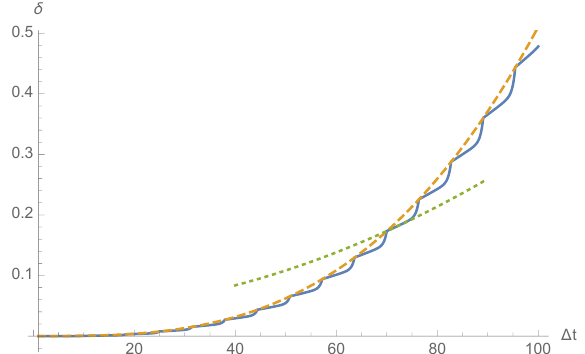
Figure 3. The growth of the eikonal phase δ , related to the OTOC through (1.9), of two scalar op- erators at a fixed spatial separation in extremal BTZ, computed within the geodesic approximation (solid blue line). The growth is cubic on average and can be very well approximated by the func- tional dependence depicted in orange (dashed), which scales as ∼ 4 r 2 + t 3 On top of this average growth, we find a sawtooth-like modulation that starts with a quadratically growing piece, followed by an exponential growth that catches up with the overall t 3 growth. One of the phases of t 2 growth is depicted by superimposing the dashed green (dotted) line, obtained by summing the quadratic contributions of a fixed 20 images. This figure is discussed in detail in section